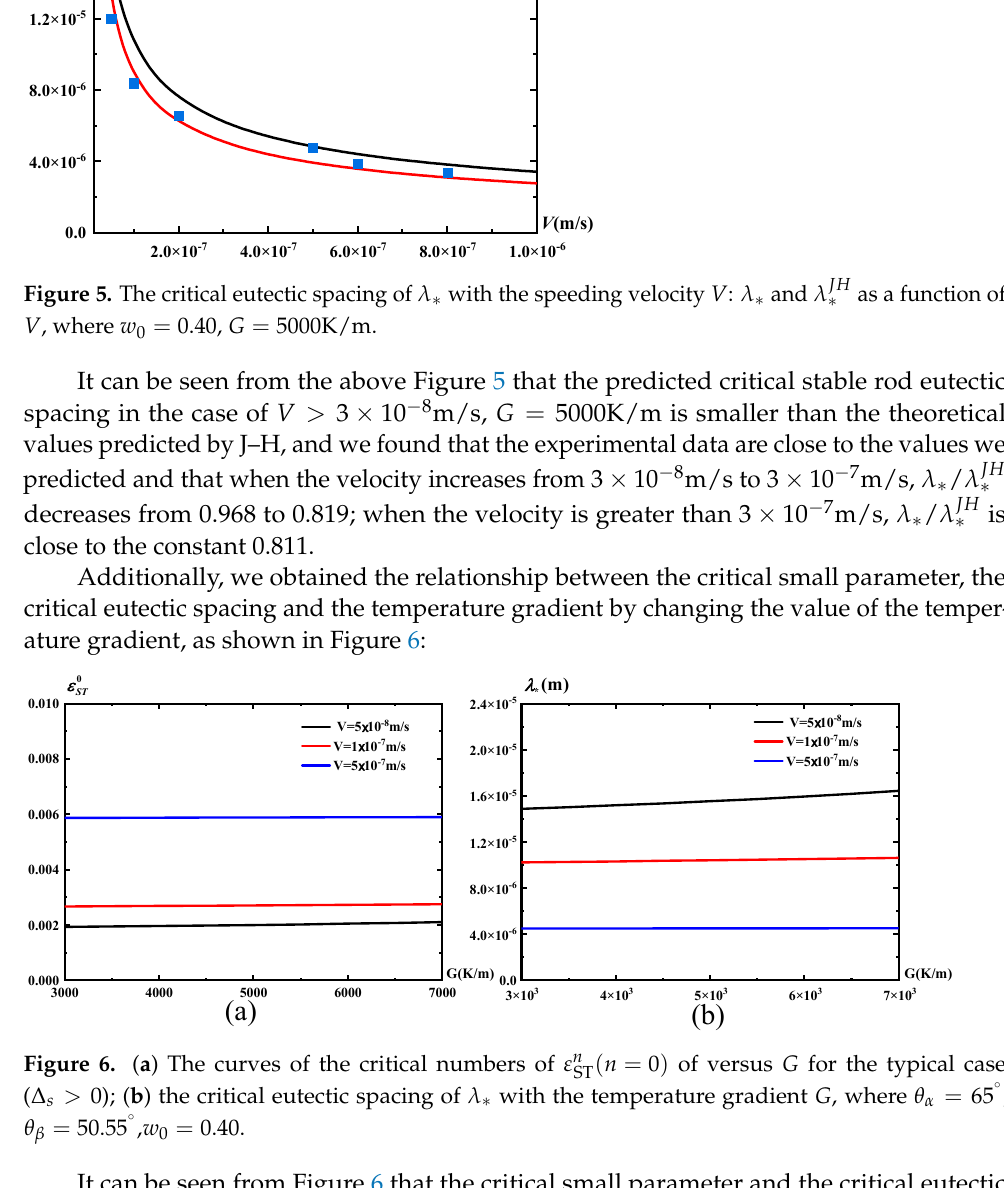
Figure 6. ( a ) The curves of the critical numbers of 𝜀 (cid:2903)(cid:2904)(cid:3041) (cid:4666)𝑛 (cid:3404) 0 ) of versus 𝐺 for the typical case ( 𝛥 (cid:3046) (cid:3408) 0 ); ( b ) the critical eutectic spacing of 𝜆 ∗ with the temperature gradient 𝐺 , where 𝜃 (cid:3080) = 65 ° , 𝜃 (cid:3081) = 50.55 ° , 𝑤 (cid:2868) (cid:3404) 0.40 .